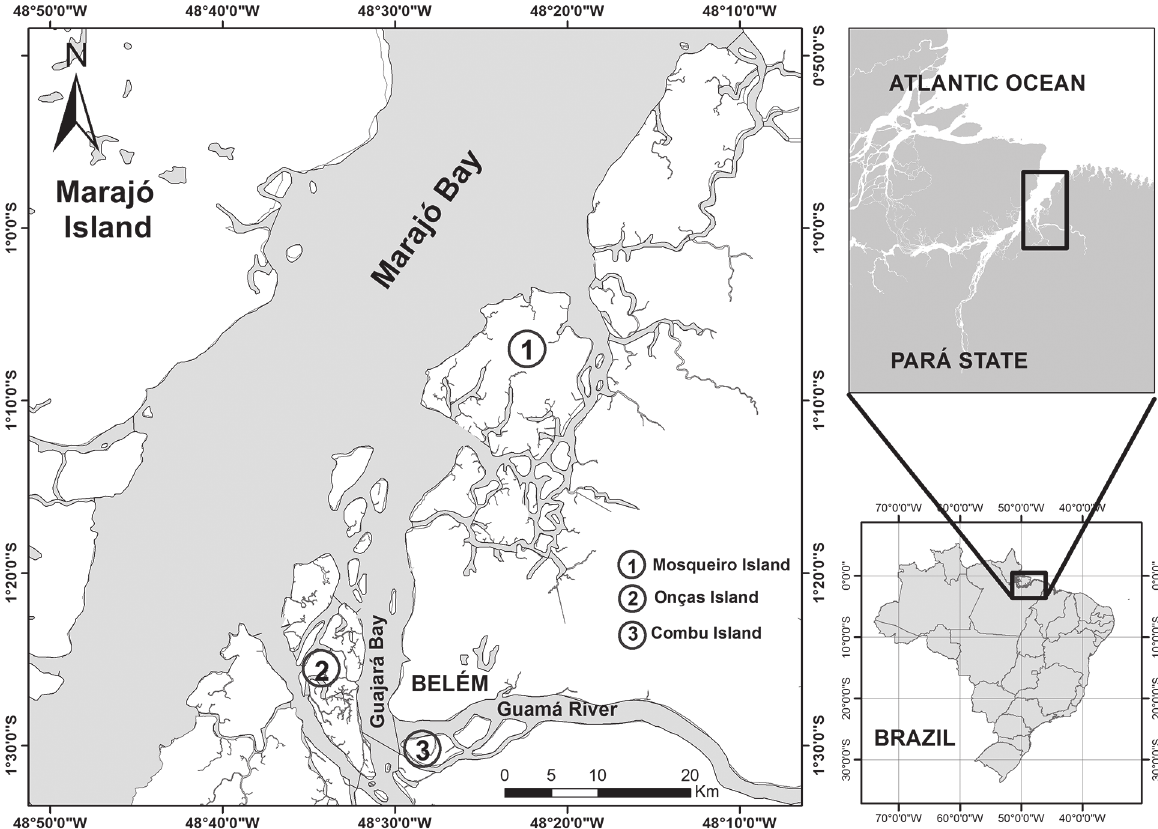
Figure 1 - Location map of study area in the mouth of the Guamá River, and Guajará and Marajó Bays, its adjacent islands: (1) Combu; (2) Onças and (3) Mosqueiro, Amazon Estuary, northern